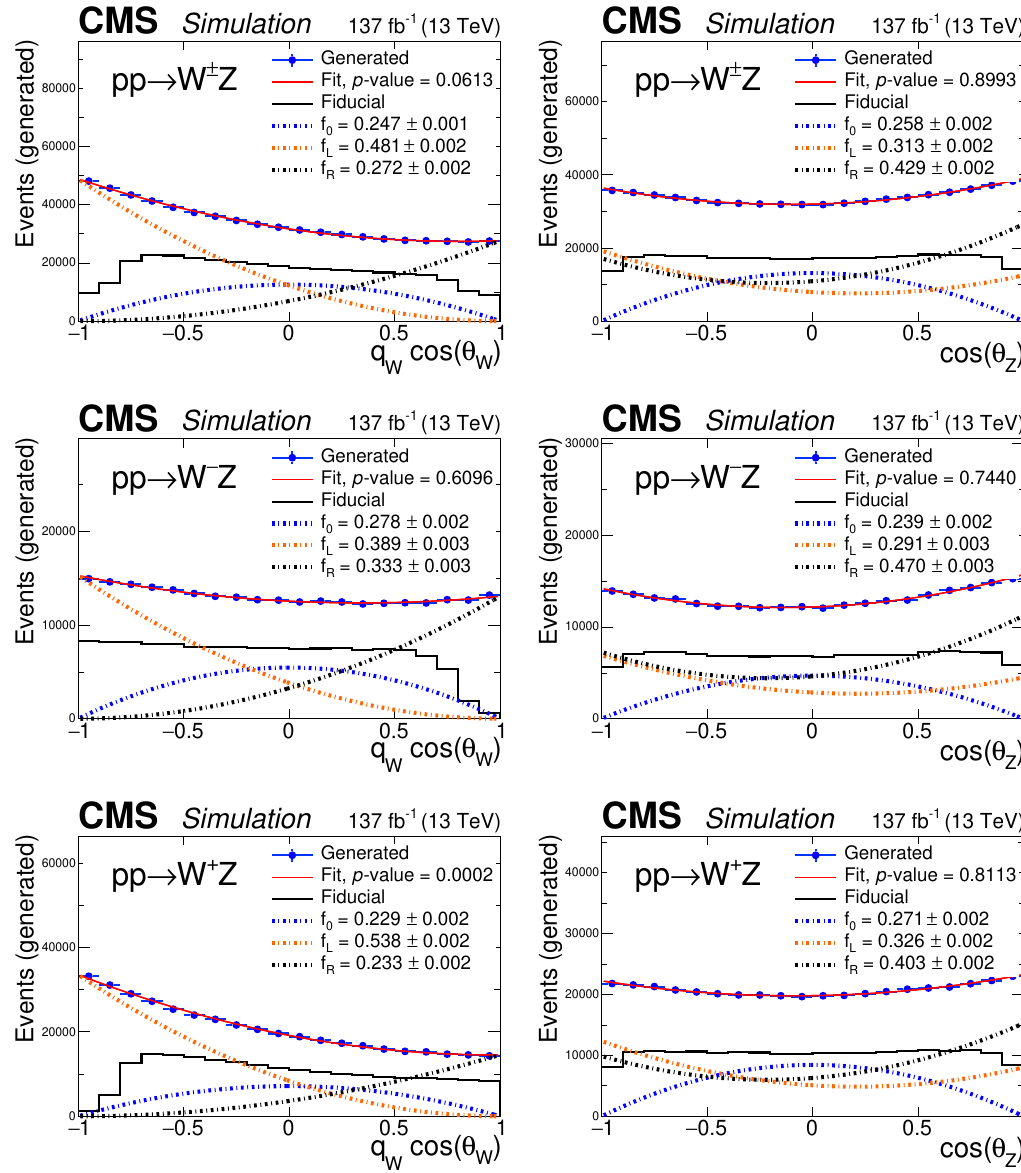
Figure 9 . Distribution of the cosine of the polarization angle in the helicity frame at the generator level for the nominal signal sample: from left to right, W and Z bosons; from top to bottom, total (inclusive) final state, negatively charged final state, and positively charged final state. For the W boson, the cosine of the polarization angle is multiplied by the W boson charge (q points are the MC predictions in the total phase space, with vertical bars representing the overall MC statistical uncertainty. The solid red line shows the best quadratic fit to the MC prediction, and the different dashed lines each of the polarization components obtained in the fit. The solid black line shows the distribution of the same variable restricted to the fiducial phase space, showing how kinematic requirements break the quadratic dependence of the differential cross section. The p -value, obtained from a χ 2 test, is included in the